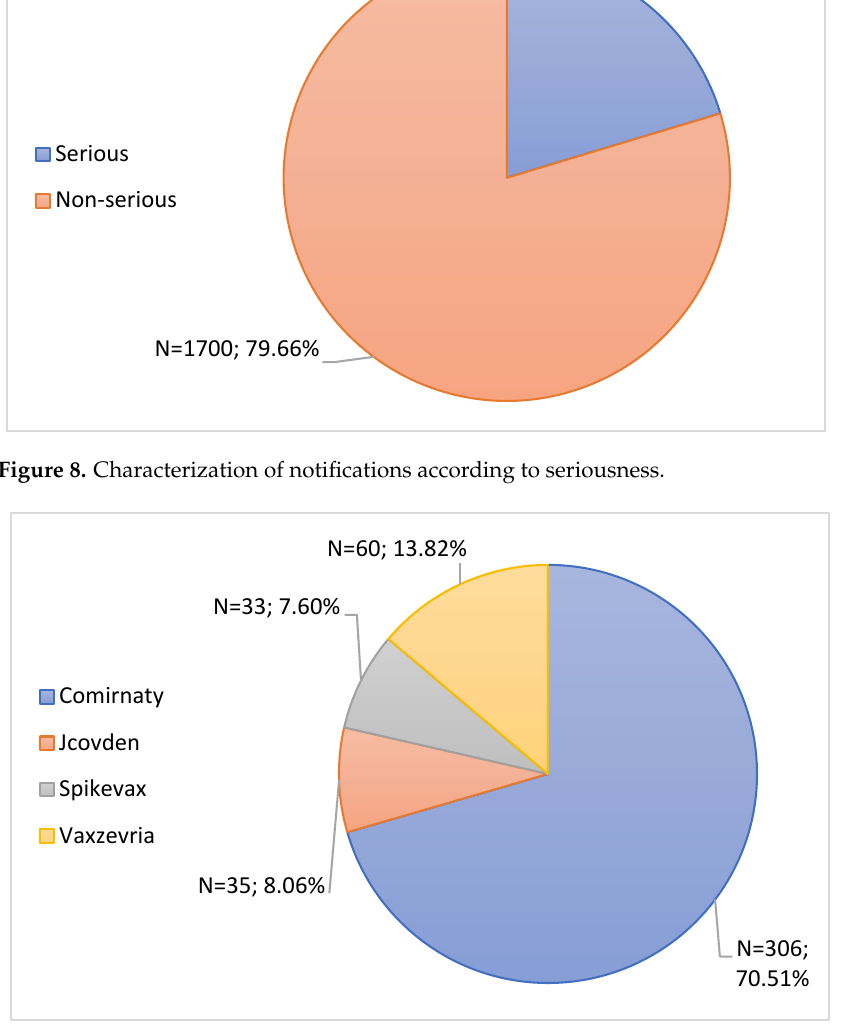
Figure 9. Characterization of serious notifications according to the brand name of the vaccine ad- ministered.